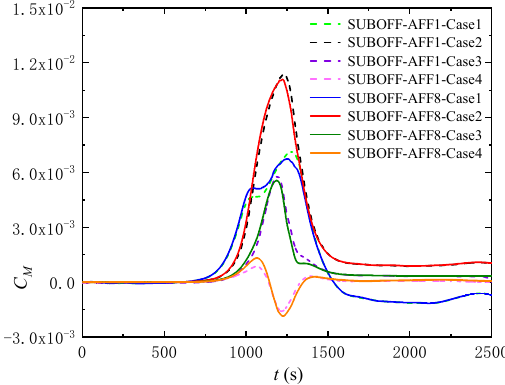
Figure 16. Time series of the nondimensional moment.